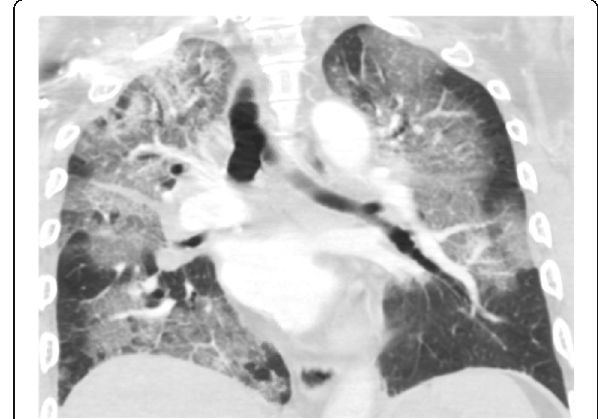
Fig. 2 Computed Tomography coronal image through the chest of a patient wih EVALI showing bilateraly patchy ground glass